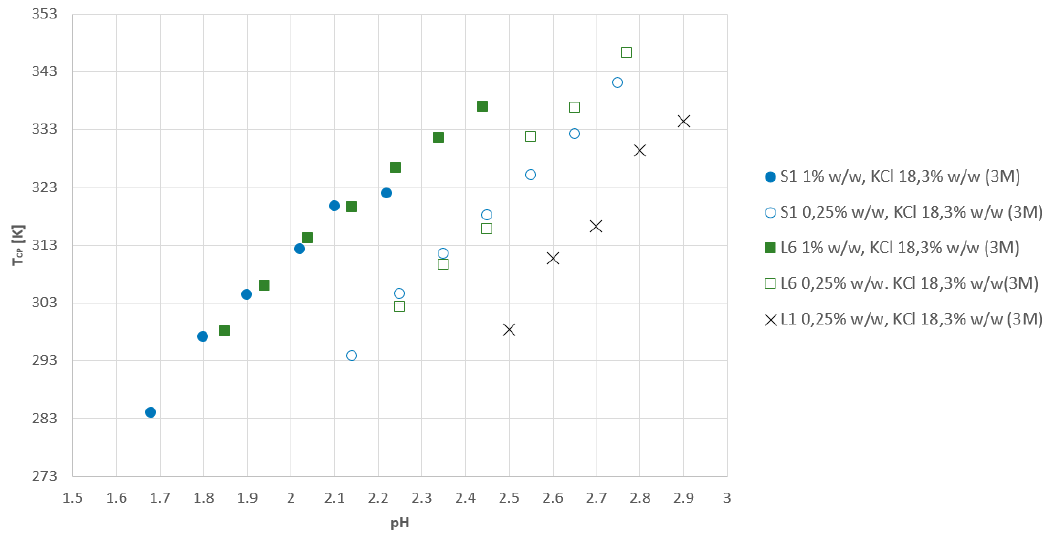
Figure 8. T CP values of poly(acrylic acid) (PAA) (L1), linear poly(acrylic acid- co -methyl acrylate) (P(AA- co -MA)) (L6), and star-shaped P(AA- co -MA) (S1) with different concentrations as a function of pH.